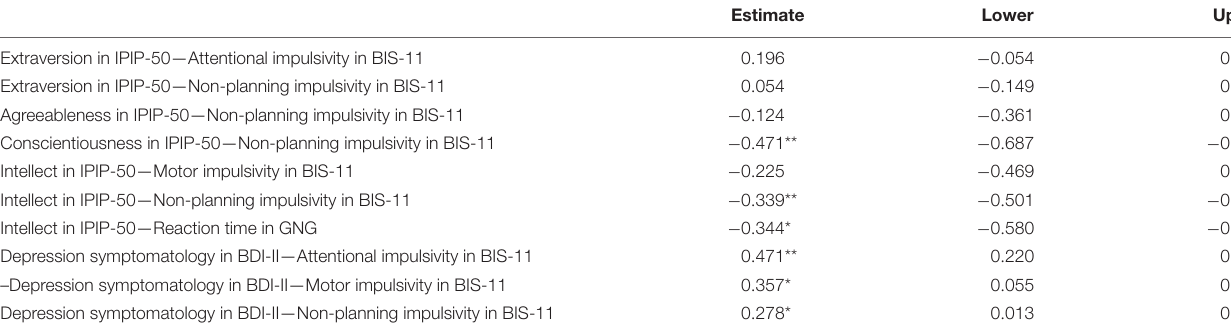
TABLE 5 | Standardized regression weights for all relations.